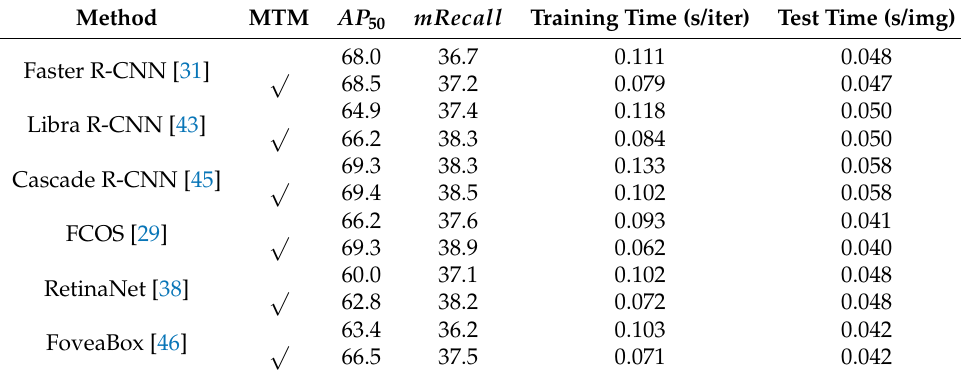
Table 5. The performance of various detection methods with or without MTM.